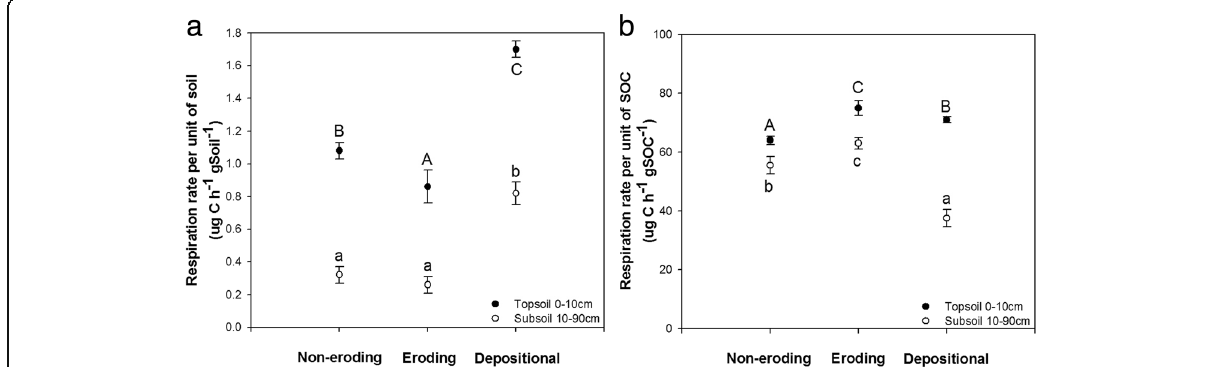
Fig. 4 Observed respiration rates for topsoil and subsoil as a function of the geomorphic position (non-eroding, eroding and depositional). The respiration per unit soil ( a ) and per unit of SOC ( b ) is given. The same letter indicates no significant differences between different geomorphic positions for the two depth classes ( p < 0.1, tested for panel a , b separately)